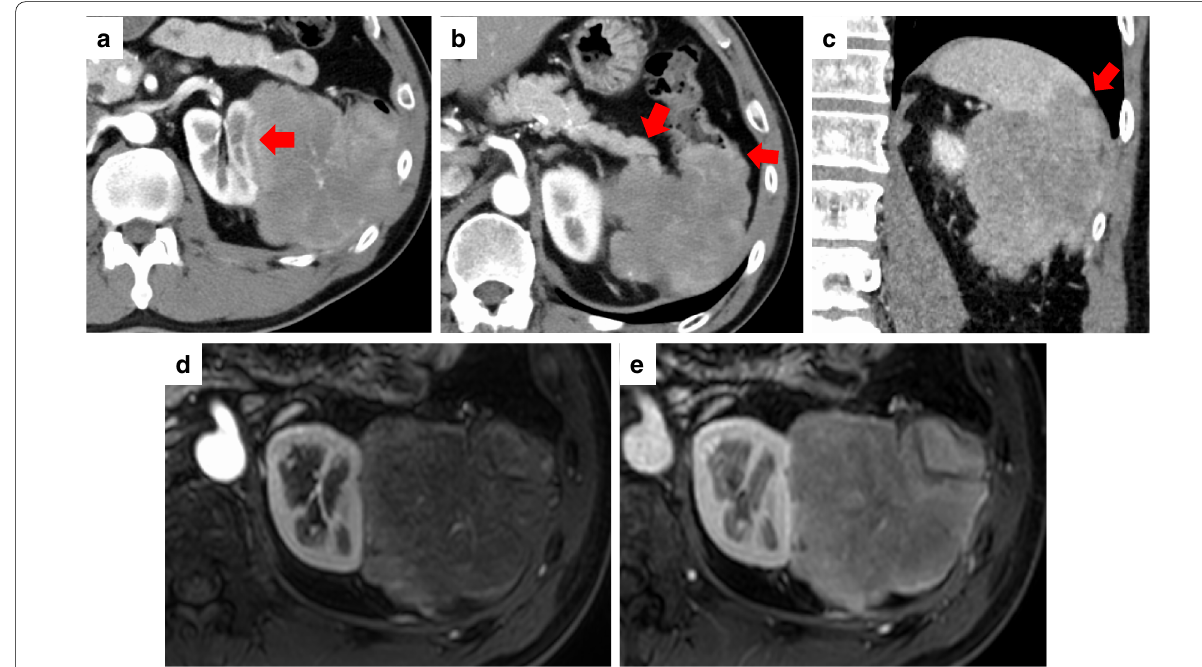
Fig. 1 a – c Abdominal contrast‑enhanced CT scan showed a huge mass in the spleen. The red arrows point out the involvement of surrounding organs: a left kidney, b pancreatic tail and descending colon, c left diaphragm. d Early phase of abdominal contrast‑enhanced MRI. e Late phase of abdominal contrast‑enhanced